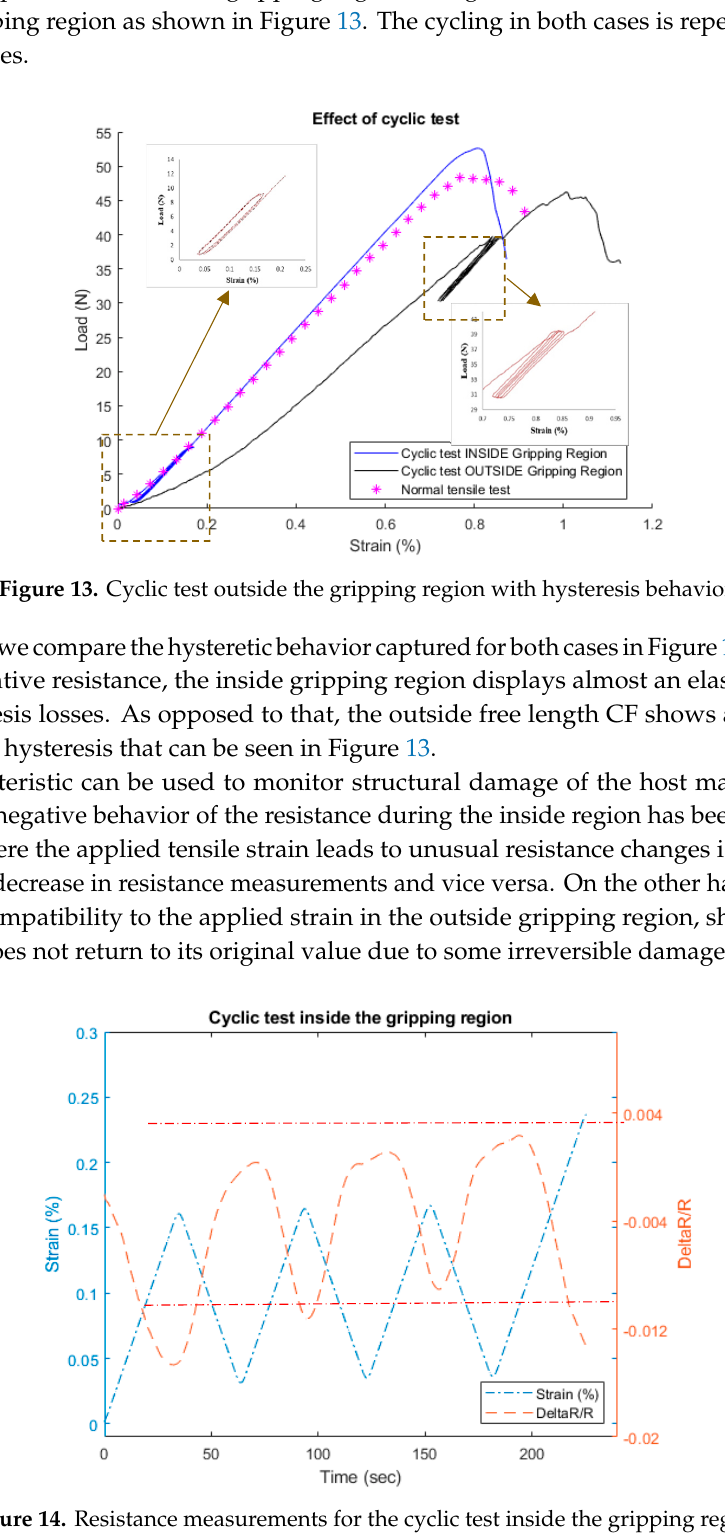
Figure 14. Resistance measurements for the cyclic test inside the gripping region.